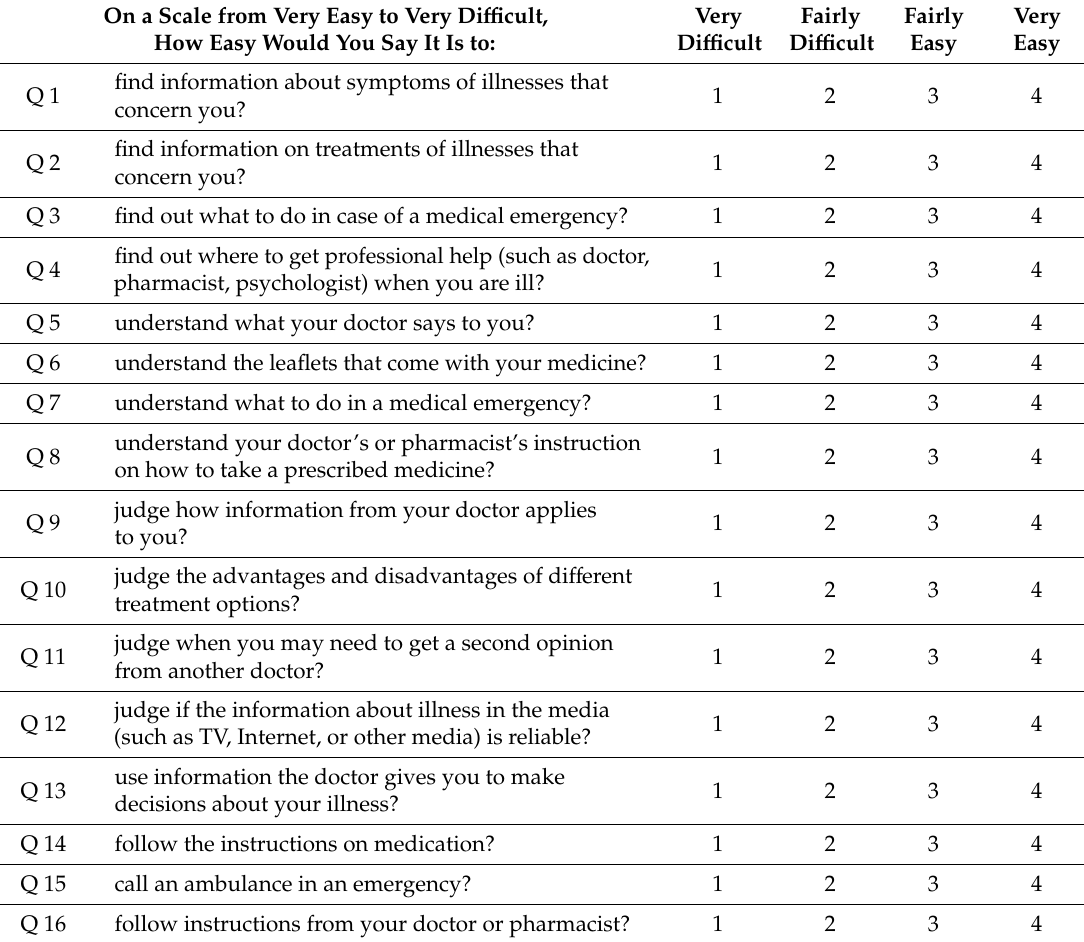
Table A1. Health literacy questionnaire